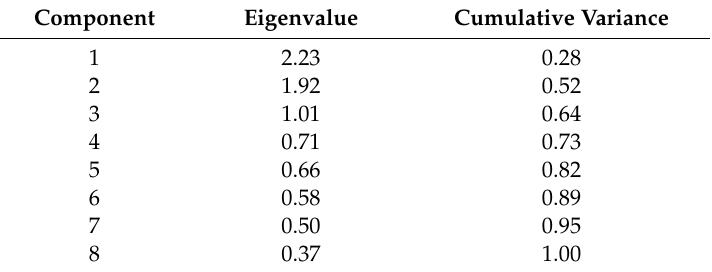
Table 6. Criteria for the factor analysis of the “highly religious” adolescents and young adults (N = 2103).